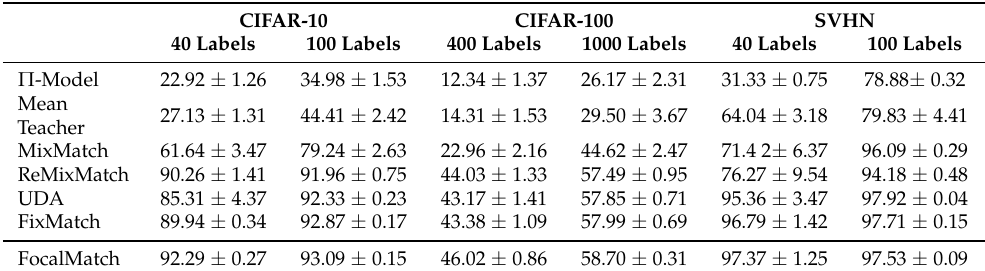
Table 1. Accuracy Comparison in Different